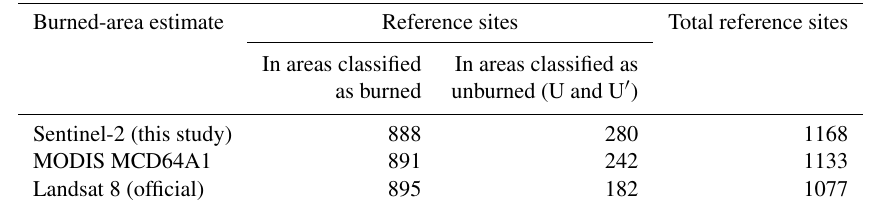
Table 1. Adjusted, stratified subsamples of reference sites to validate burned-area estimates.